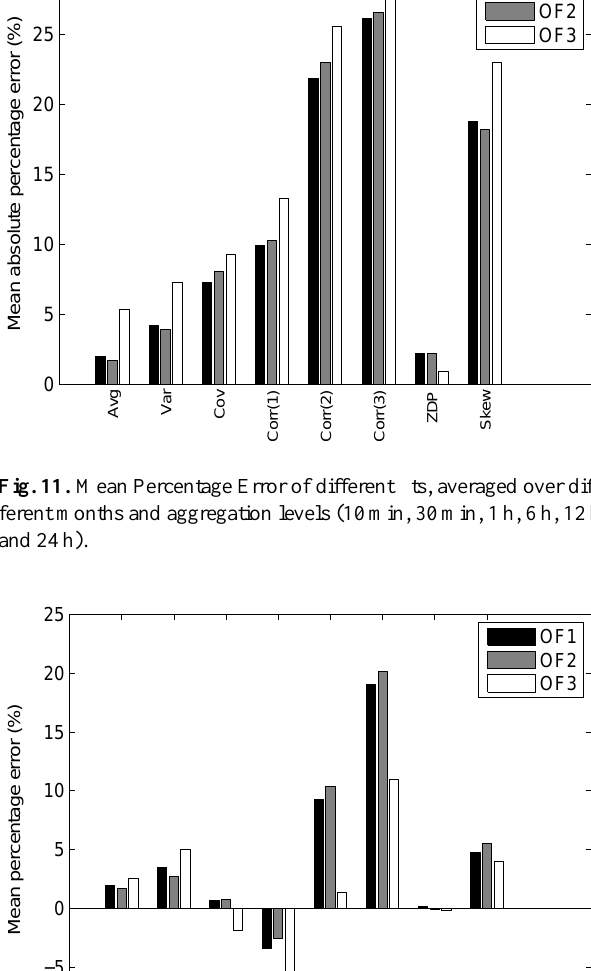
Fig. 10: Mean 10 minute rainfall, average simulation result vs. observations